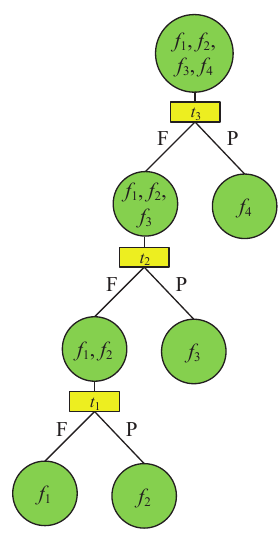
Figure 3. Fault-diagnosis tree of a certain control system.